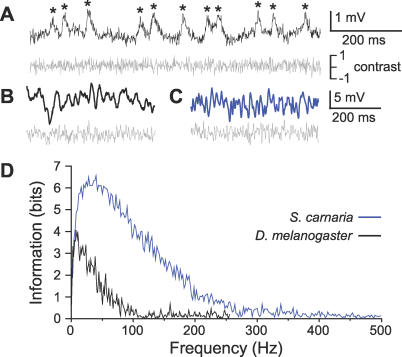
Intracellular Recordings of Voltage Responses and the Distribution of Information across Frequencies in R1–6 Photoreceptors of D. melanogaster and S. carnaria
(A) Quantum bumps (*) recorded from D. melanogaster in response to continuous illumination by the white-noise stimulus (lower trace, grey), which was attenuated by 5.5 log units to give a mean effective photon rate of 9 s−1.(B) Average responses of a D. melanogaster R1–6 photoreceptor to 50 repetitions of a randomly modulated light of mean contrast 0.32.(C) The corresponding average response of an R1–6 photoreceptor from S. carnaria. Note that the responses in (B) and (C) have dissimilar waveforms because they were generated by different random sequences of intensity modulation, shown in grey beneath each voltage record. In both (B) and (C) the mean stimulus intensity was set to approximately 5 × 106 effective photons s−1. Note that S. carnaria R1–6 responses (C) vary more rapidly than D. melanogaster (B).(D) This faster response gave the S. carnaria R1–6 a wider bandwidth, as demonstrated in (D) by plotting the distribution of information across response frequency for the two cells.